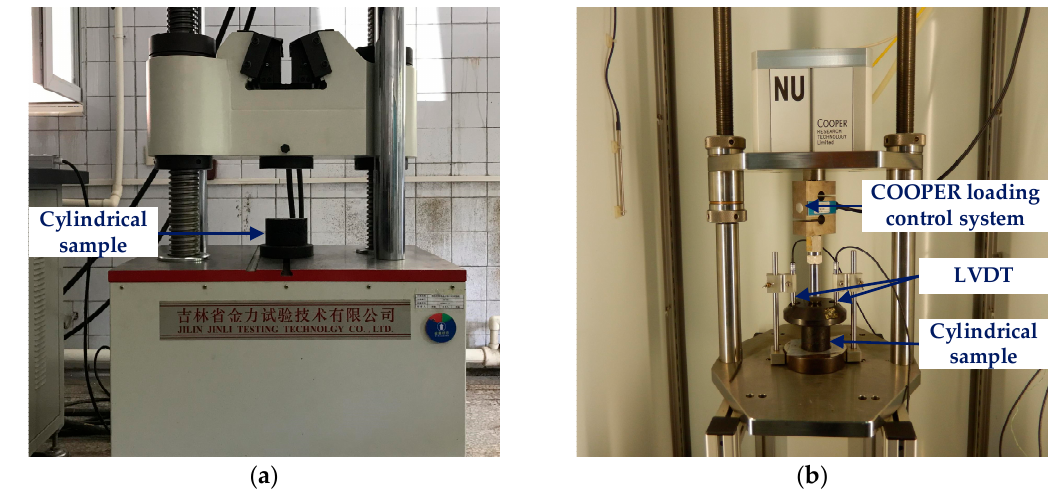
Figure 2. High ‐ temperature viscoelastic property tests: ( a ) Uniaxial compression failure test; and, ( b ) Uniaxial compression static creep test.